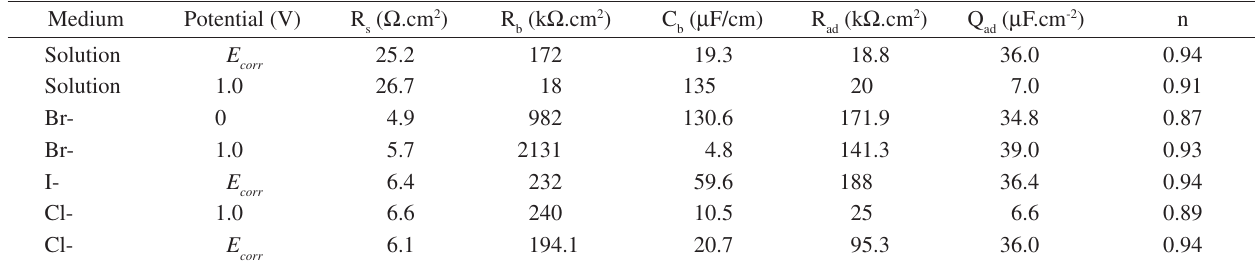
Table 2. Simulated data for Ti6Al4V alloy in citric acid solution with and without halides.